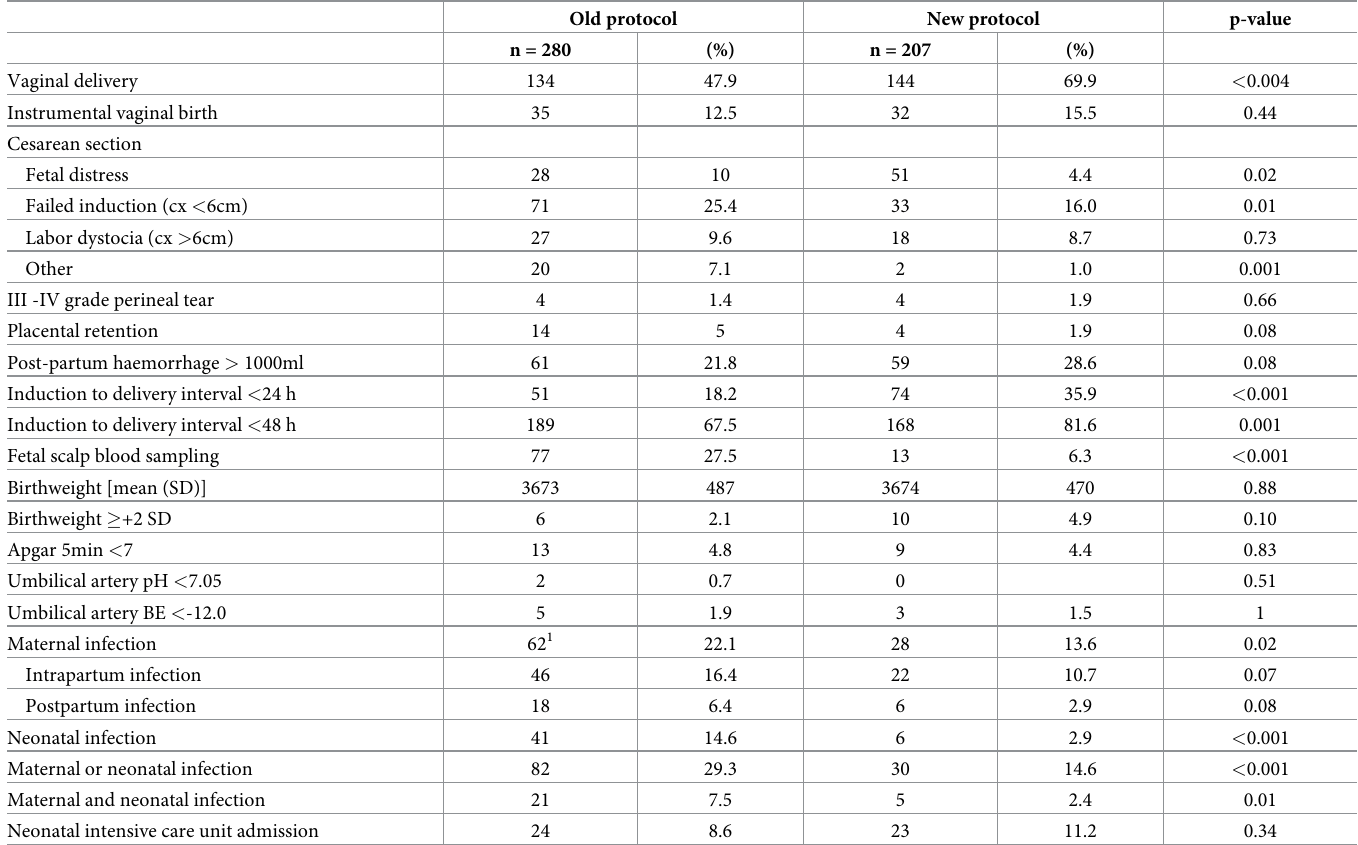
Table 4. Delivery